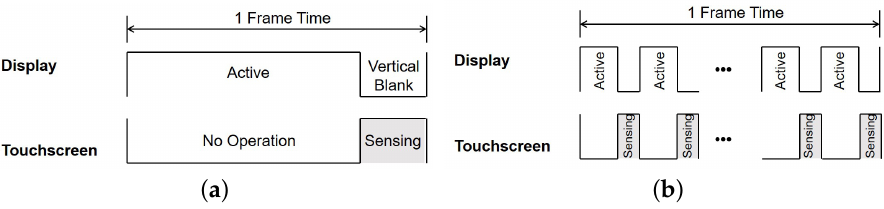
Figure 11. Touch sensing methods during the vertical blank periods. ( a ) Sensing during one vertical blank period. ( b ) TDMS sensing during divided vertical blank periods in the middle of a frame.